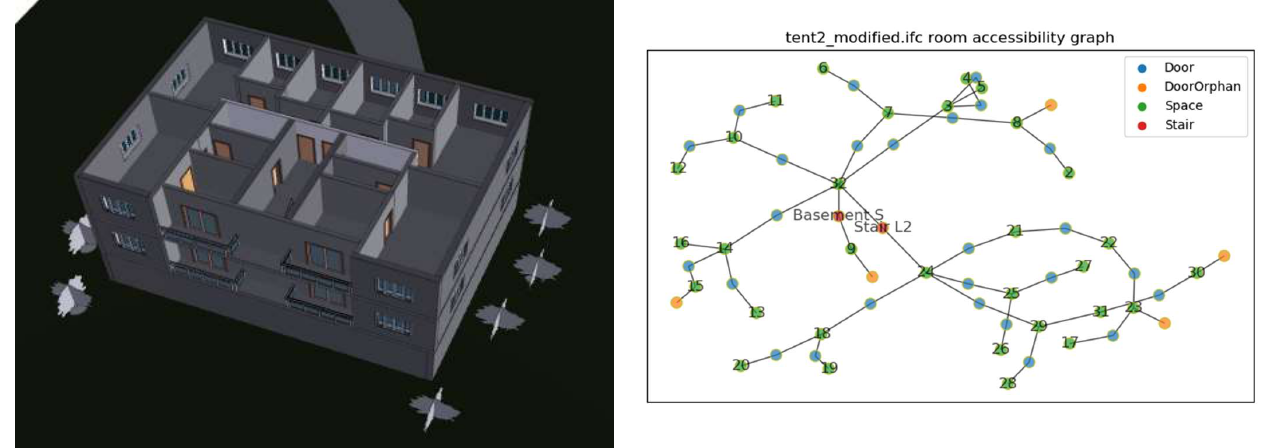
Figure 2. A building model and the corresponding calculated accessibility graph. Orphan doors were the doors with only one connected space (external or terrace